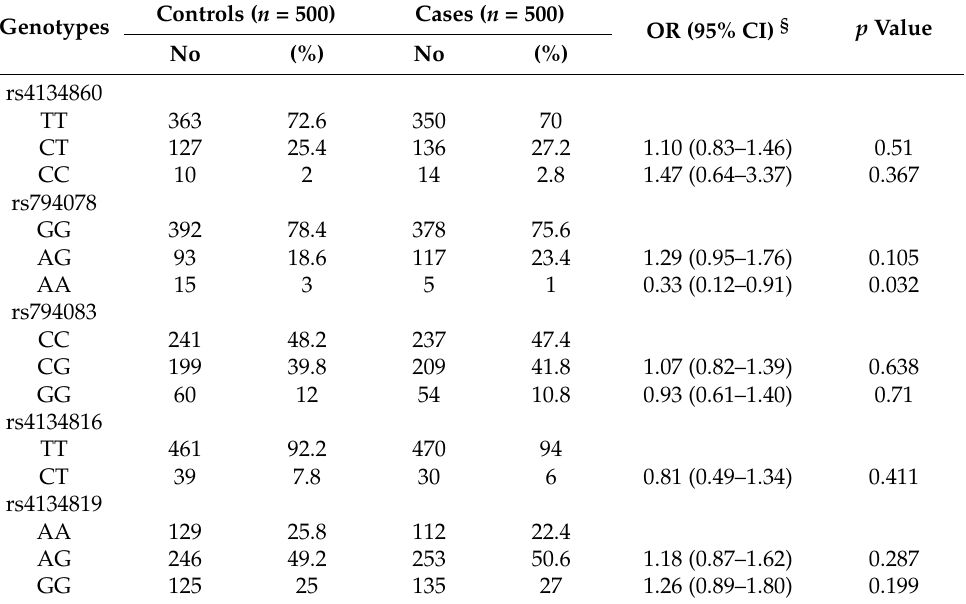
Table 2. Genotype frequencies of XAB2 among cases and controls and their association with gas- tric cancer.